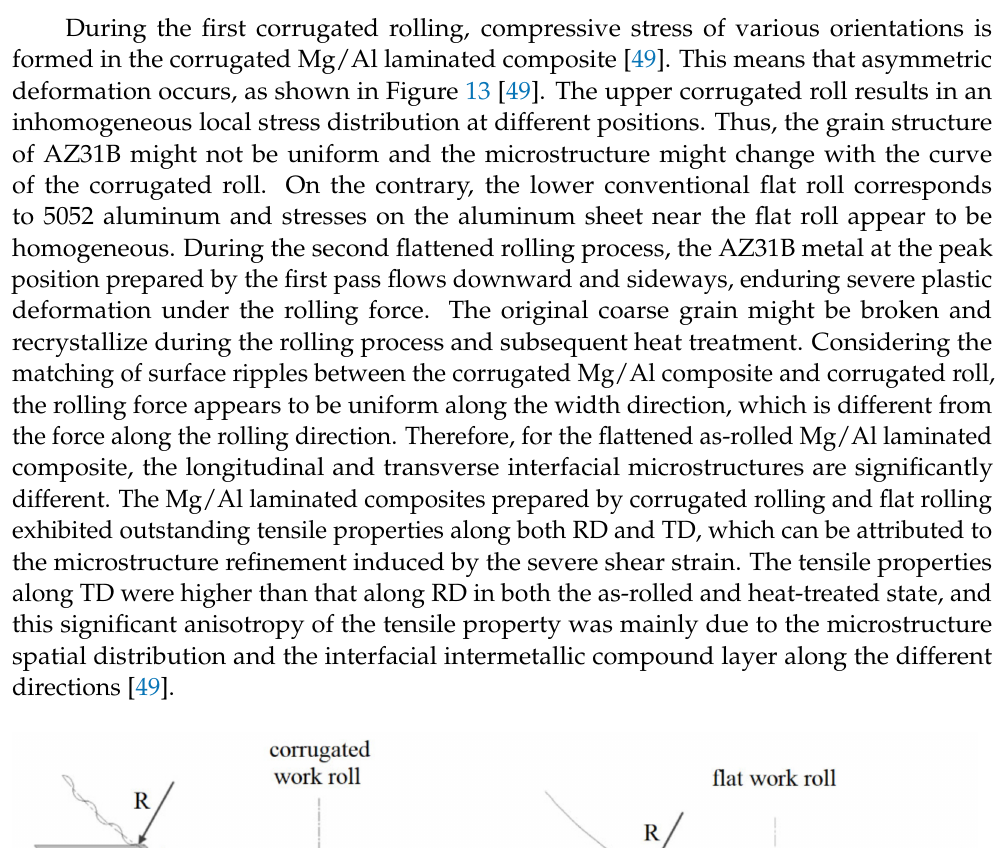
Figure 12. Schematic illustration of corrugated rolling and flat rolling, reproduced from [50], with permission from Elsevier, 2021.